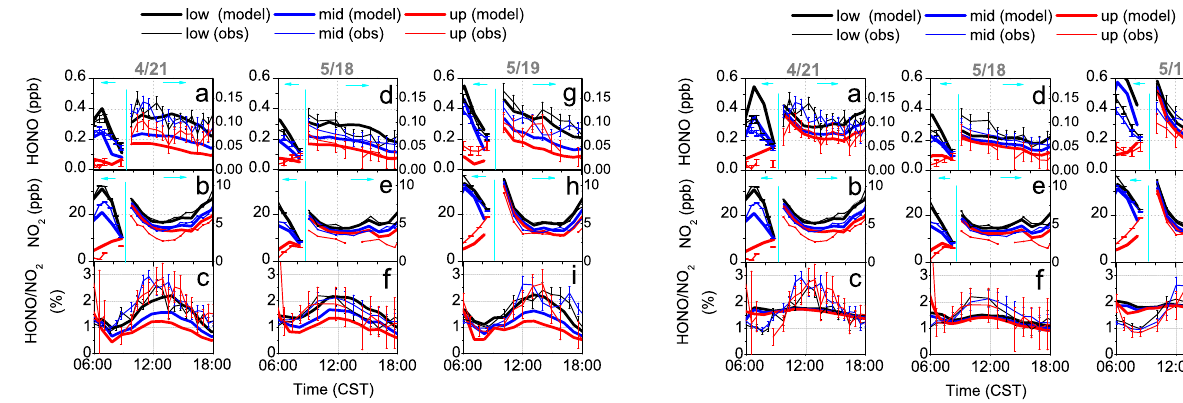
Fig. 5. Comparisons between observations and model results with a photolytic HONO source on aerosol only. Shown here are daytime HONO (a, d, g) , NO 2 (b, e, h) , and HONO/NO 2 ratios (c, f, i) in the lower (black), middle (blue), and upper (red) height altitudes on 21 April (left panel), 18 May (middle panel), and 19 May (right panel). HONO and NO 2 mixing ratios after 09:00CST were magnified with a different scale on the right